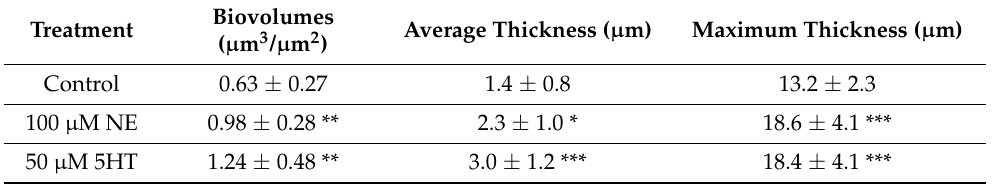
Figure 1. Effect of the treatment of E. faecium NCIMB10415 with 100 µM NE and 50 µM 5HT for 48 h on biofilm formation on glass surface, measured by CLSM. Both treatments increase the biofilm volume and thickness. Table 1. Effect of the treatment of E. faecium NCIMB10415 with 100 µM NE and 50 µM 5HT for 48 h on biofilm formation (biovolume, average thickness, and maximum thickness) on glass surface, measured by CLSM. Both treatments increase the biofilm volume and thickness. The results are expressed ± SD *** p ≤ 0.001, ** p < 0.01, * p < 0.05.